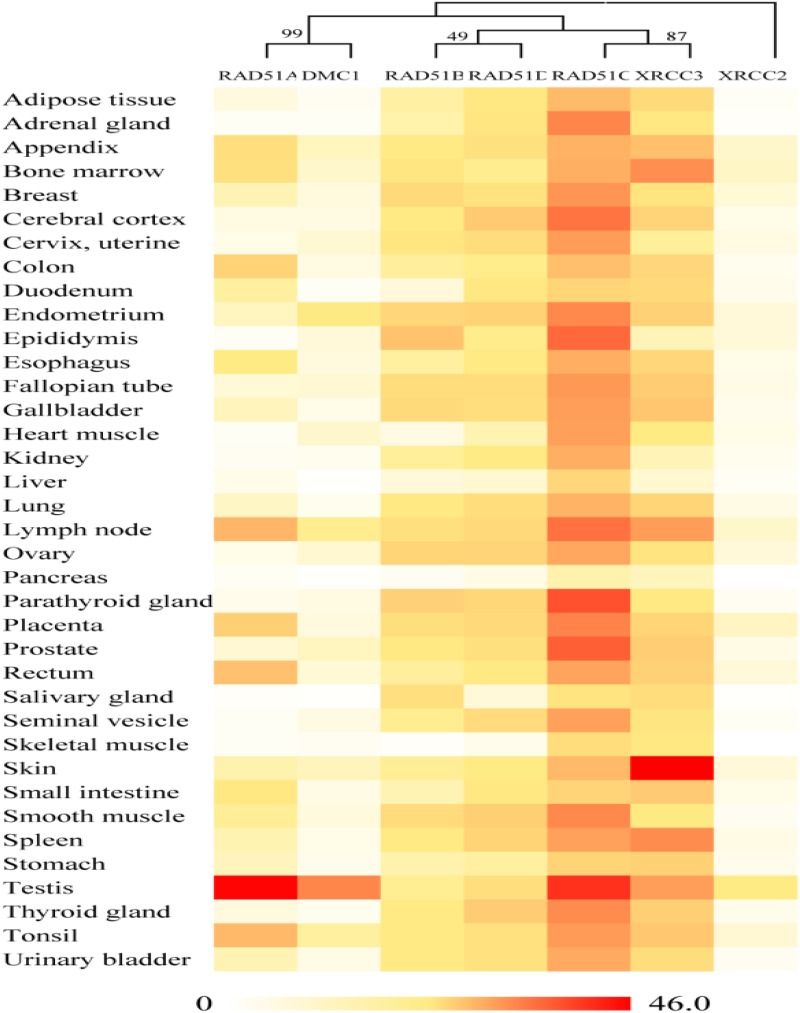
Gene expression patterns of RAD51 in humans using RNA-Seq data from the Human Protein Atlas database (HPA). RNA-seq gene expression profiles for 7 human RAD51 proteins across 37 human tissues. Mean Expression Level indicates the mean, prenormalization mRNA expression level of each RAD51 (in TPM) across all tissues.